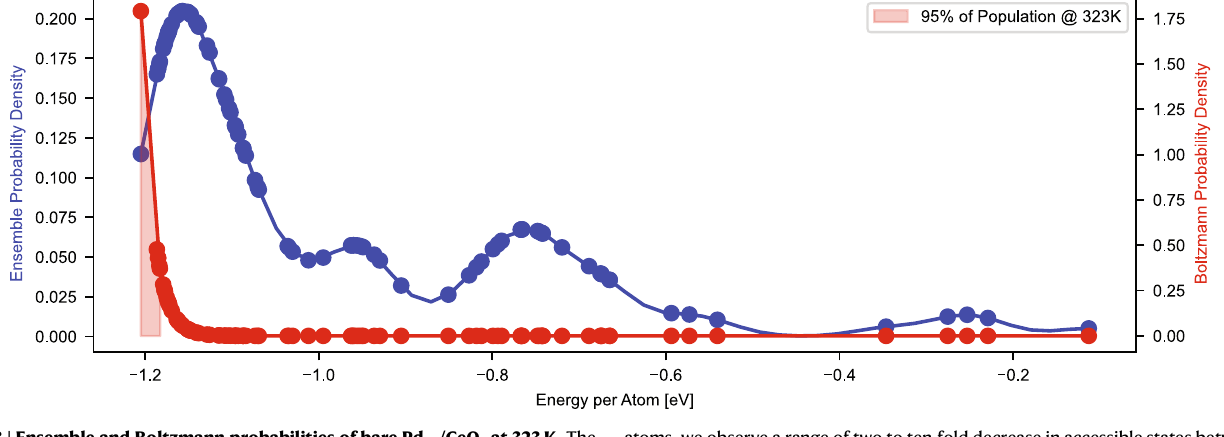
Fig. 3 | Ensemble and Boltzmann probabilities of bare Pd 20 /CeO 2 at 323K. The numberofdiscretestatesmeetingthe95%cutoffcriteriadoublesfrom4to8when the system is bare versus saturated with CO. For cluster sizes between 5 and